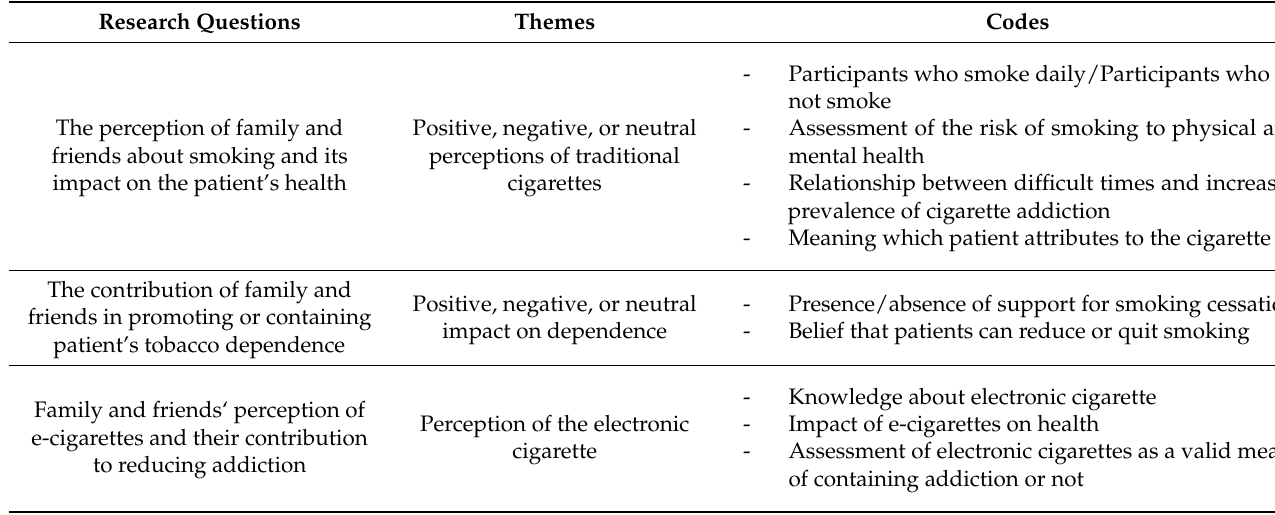
Table 3. Themes and